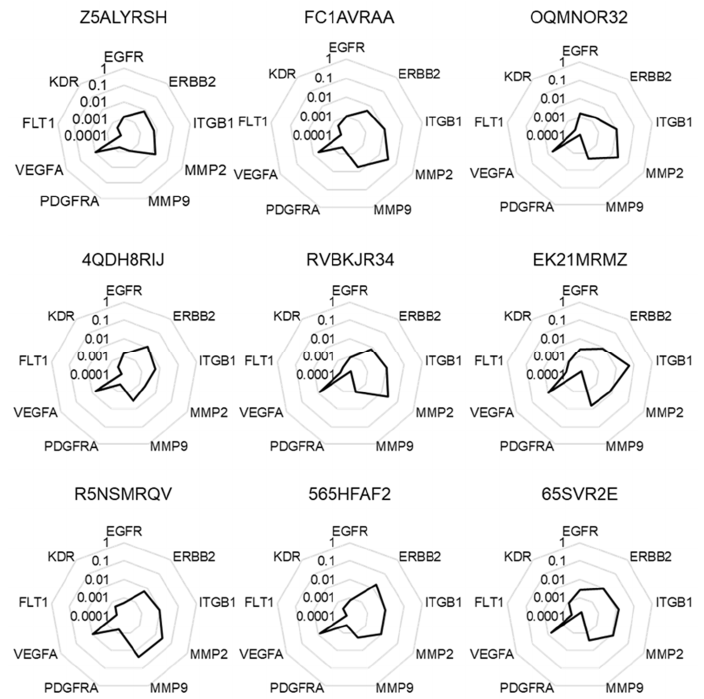
Figure 1. Molecular signatures without normalization. The di ff erent radar graphs are showing the molecular signature of each tumor sample when expression data were expressed according to the mean expression of two independent housekeeping genes GAPDH and 18S (2 − ∆ Ct